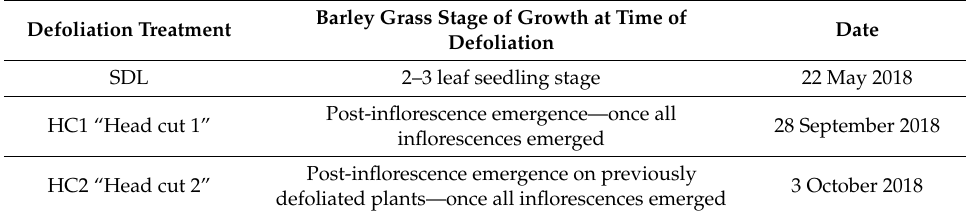
Table 4. The defoliation regimes of three individual defoliations of barley grass plants planted at five di ff erent seedling densities and at two stages of growth under greenhouse conditions at Wagga Wagga, New South Wales